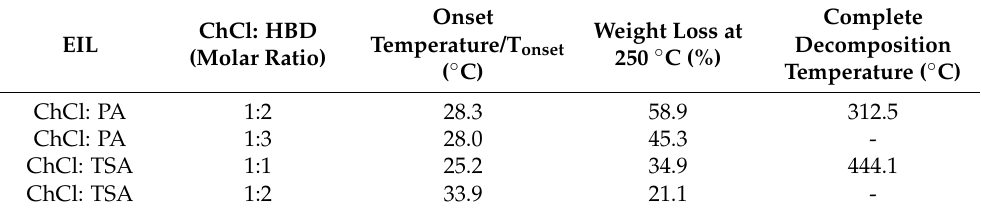
Table 1. Thermal characteristics of the synthesized acidic